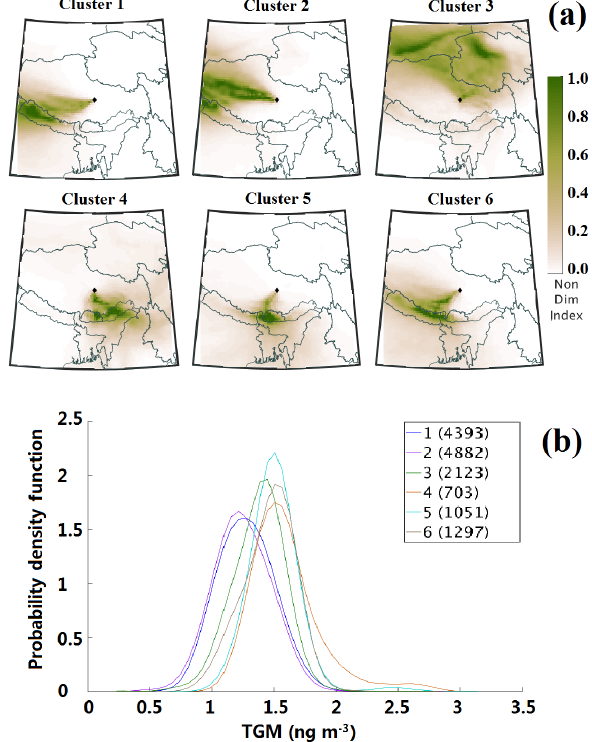
Figure 10. Clusters of air mass transport to Nam Co using WRF- FLEXPART back trajectories (a) and probability density function of TGM concentrations for each cluster, with the number of data points in each cluster in parentheses (b)